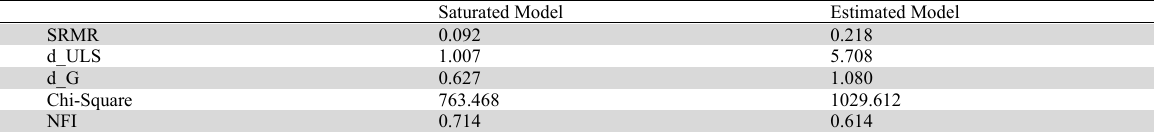
Saturated Model